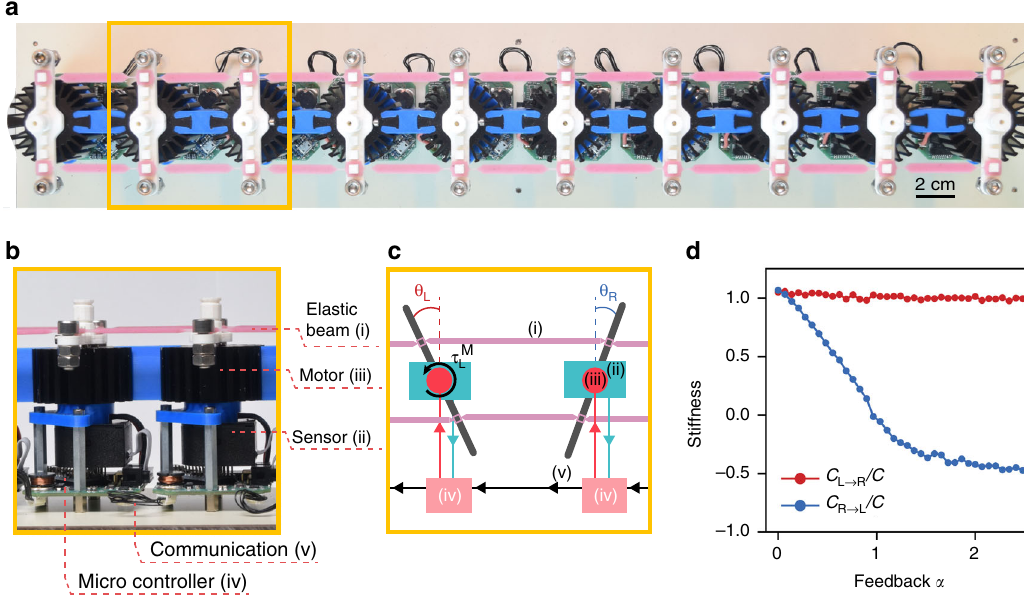
Fig. 2 Robotic metamaterial with nonreciprocal interactions. a Robotic metamaterial made of 10 unit cells mechanically connected by soft elastic beams (i). Scale bar: 2 cm. (bc) Closeup b and sketch c on two unit cells. Each unit cell is a minimal robot with a unique rotational degree of freedom that comprises an angular sensor (ii), a coreless DC motor (iii), and a microcontroller (iv). Each unit cell communicates with its right neighbor via electric wires (v). These components allow to program a control loop characterized by the feedback parameter α (see main text for de fi nition). d Rescaled torsional stiffnesses C C (red) and C C (blue) as a function of the feedback L → R / R → L /